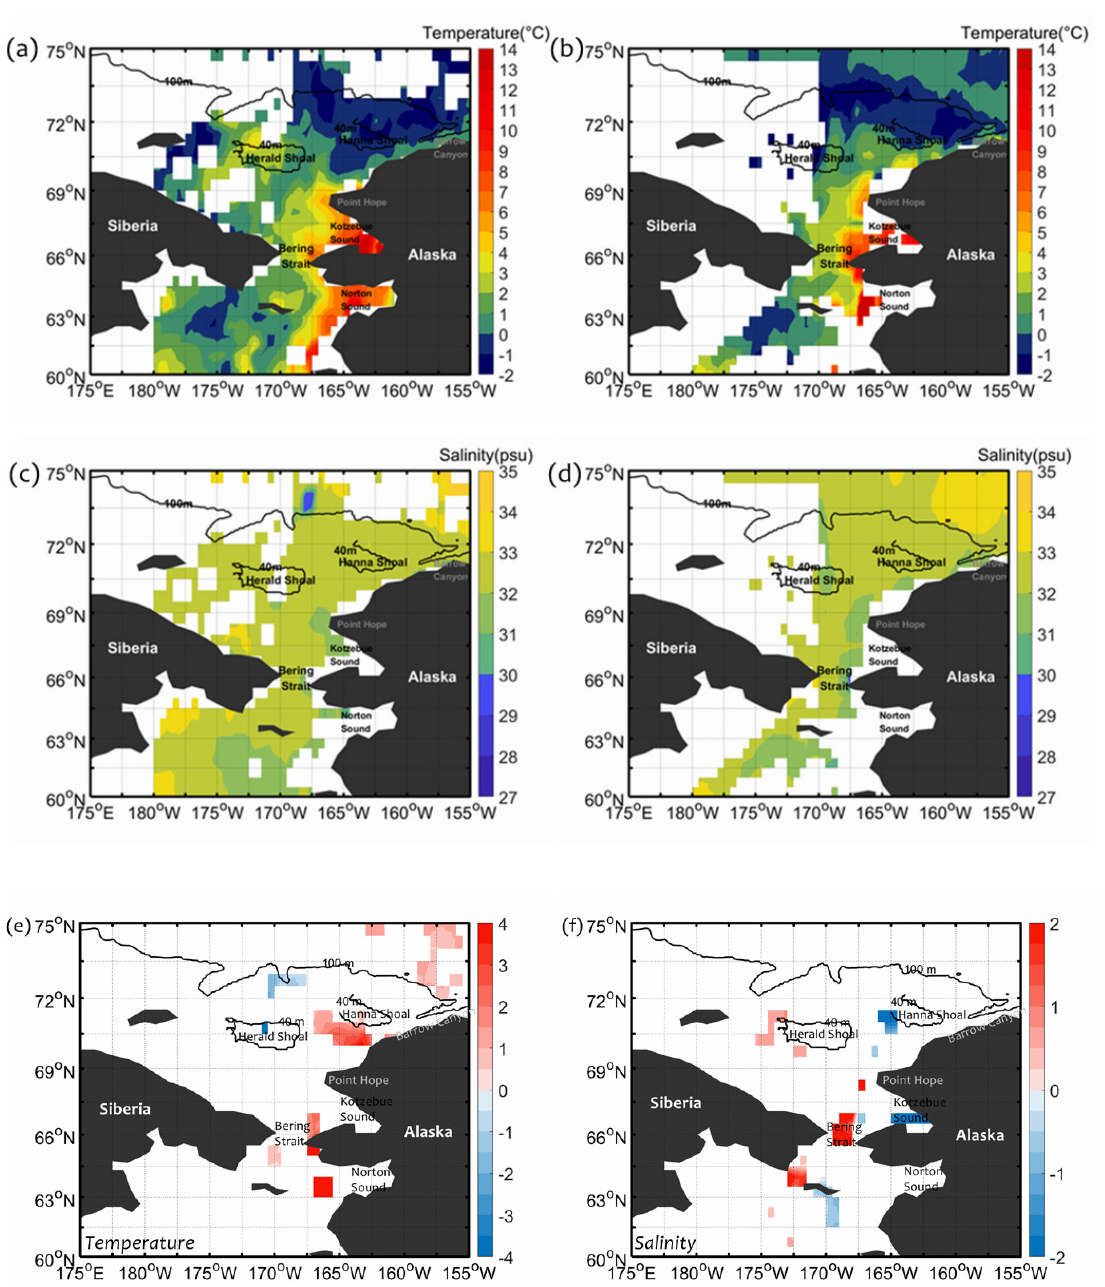
Figure 11. Bottom temperature of ( a ) pre-1997 and ( b ) post-1997 periods, and ( c , d ) for salinity; differences in ( e ) bottom temperature and ( f ) bottom salinity between the two periods. The solid black contours represent 100 m and 40 m isobaths.